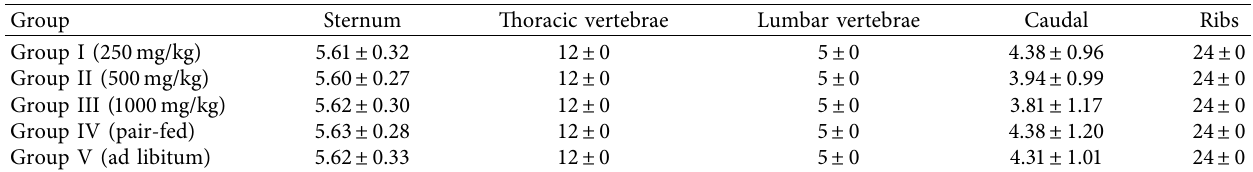
Table 10: Number of ossification centers in the axial skeleton of rat fetuses from experimental groups treated with the 80% ethanol fruit extract of Embelia schimperi